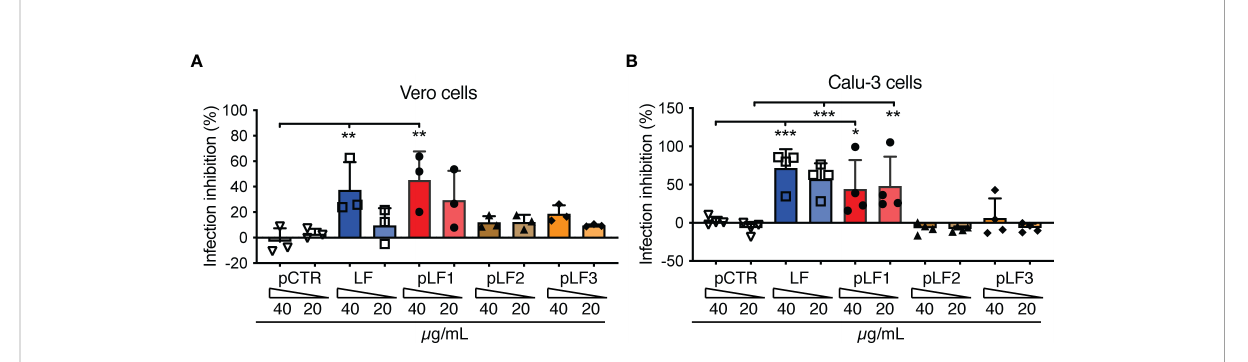
FIGURE 3 Effect of LF and the LF-derived peptides pLF1-pLF3 on the infection capability of SARS-CoV-2. Vero cells (A) or Calu-3 cells (B) grown in 96- well plates were incubated with or without LF, peptides pLF1, pLF2, pLF3 or pCTR for approx. 1 h and then infected with the authentic SARS- CoV-2 (300 TCID50/well). After 48 h, the cells were fi xed and the infection rate was assessed by In-Cell ELISA. Values show mean inhibitory capacity of LF and the indicated peptides ± SD from three (A) or four (B) independent experiments. p*<0.05, p**<0.005, p***<0.0005.